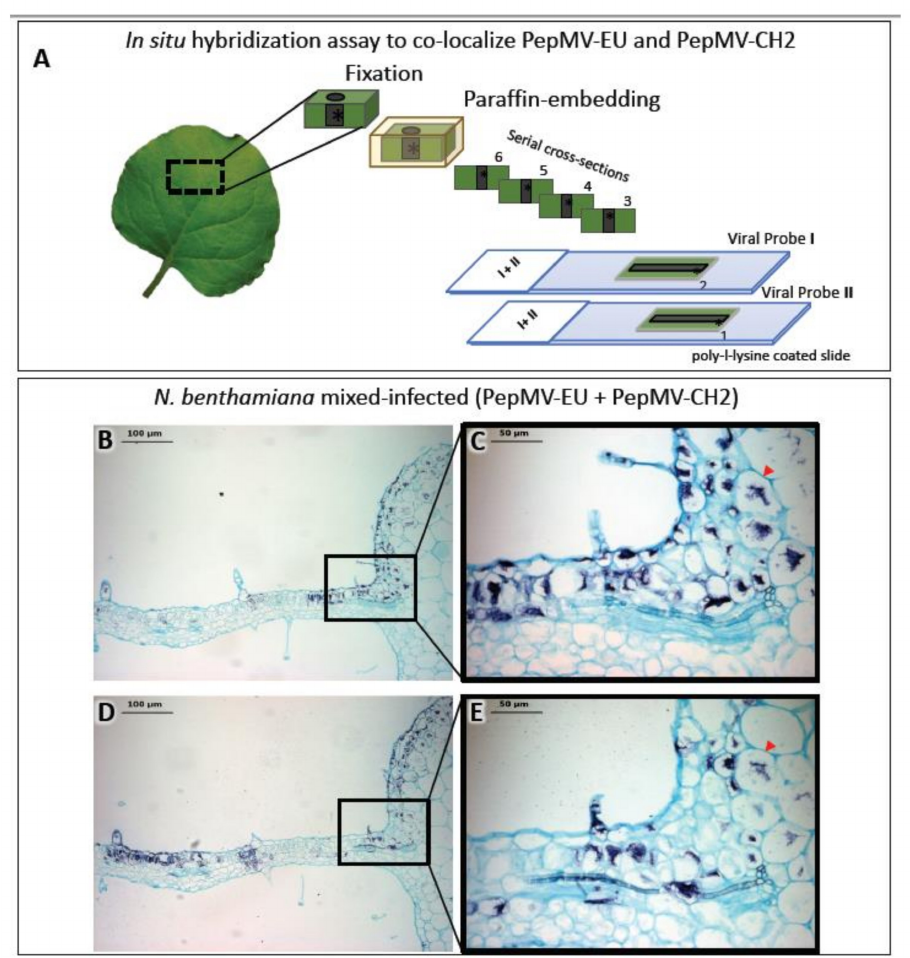
Figure 2. In situ hybridization (ISH) assay on consecutive serial cross sections of Nicotiana benthamiana leaves infected with two isolates belonging to different strains of pepino mosaic virus (PepMV-EU and PepMV-CH2). ( A ) Schematic representation of the ISH assay. Small pieces of mock and mixed infected N. benthamiana leaves were fixed with paraformaldehyde (PFA), embedded into paraffin and sectioned. The ISH was performed on consecutive leaf cross sections of the same sample by using each probe (I or II) in each slide (1 or 2), respectively. ( B , D ) Images of the ISH performed on a pair of consecutive leaf serial cross sections from mixed (PepMV-EU + PepMV-CH2) inoculated plants with either the riboprobe for PepMV-EU ( B ) or PepMV-CH2; both viruses are located in dark-blue colored areas of the leaf sections distributed in patches of infected tissue, mixed with areas of noninfected tissue. ( C , E ) Higher magnification of the area boxed in B , D , respectively. The viral RNAs of both PepMV-EU and PepMV-CH2 isolates are located in the same dark-blue colored cells (arrowhead) of the leaf, mixed together with other noninfected tissue cells, or only infected by one of the isolates. Scale bars are displayed in the images. This figure is adapted with permission from